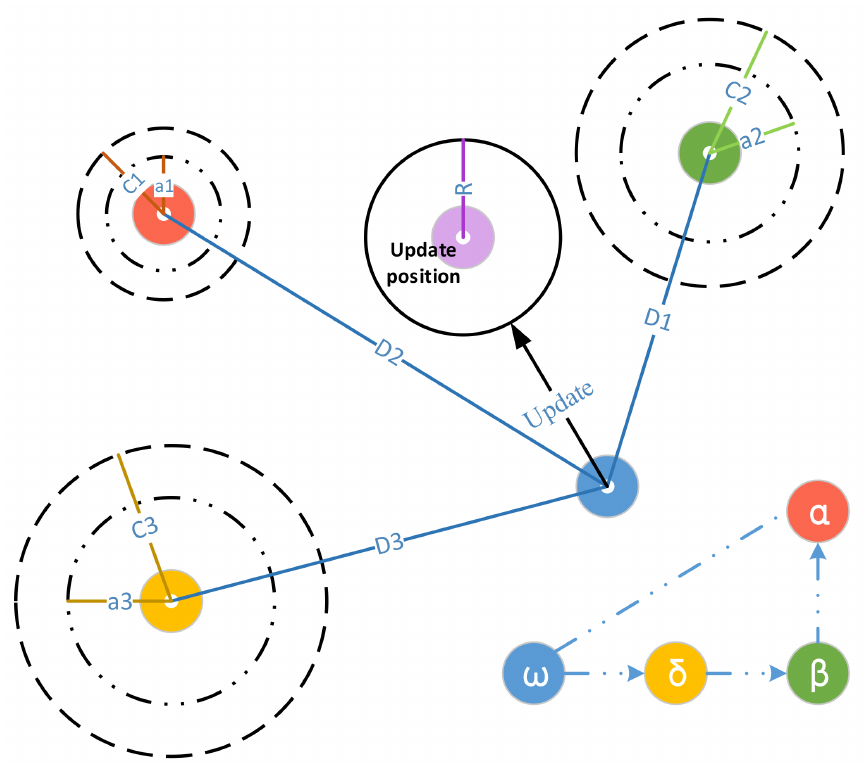
Figure 2. The updating process of the grey wolf optimization